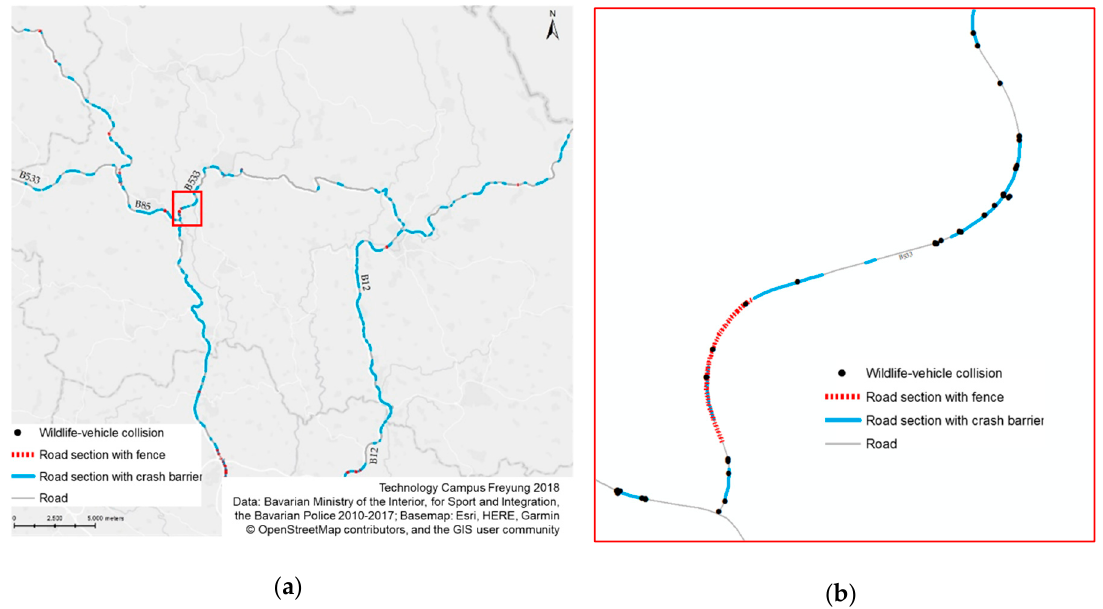
Figure 5. Spatial distribution of barriers in the research area ( a ) and in a subsection ( b ).